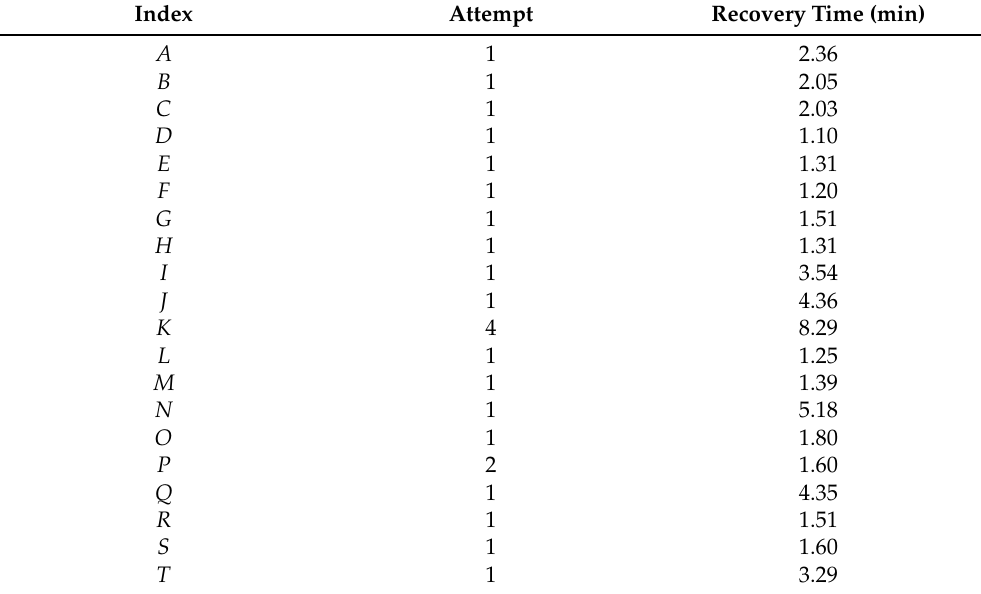
Table 7. Private key recovery attempt and